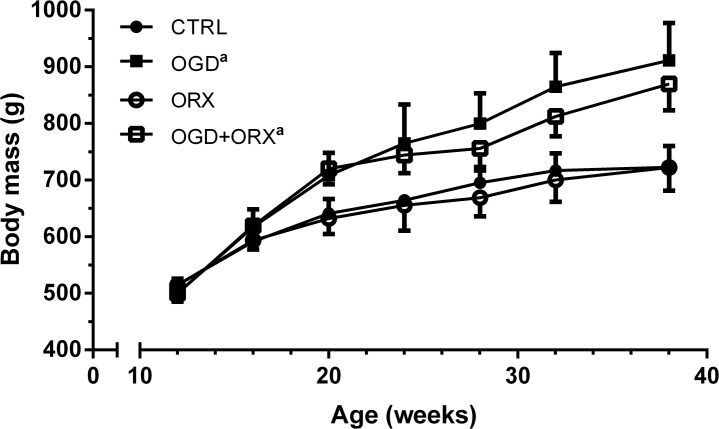
Body mass measurements.CTRL–control, OGD–obesogenic diet-fed, ORX–orchiectomised. Letters denote significant differences from respective groups at the final time point (38 weeks), p<0.05 (a vs. CTRL, b vs. OGD, c vs. ORX).